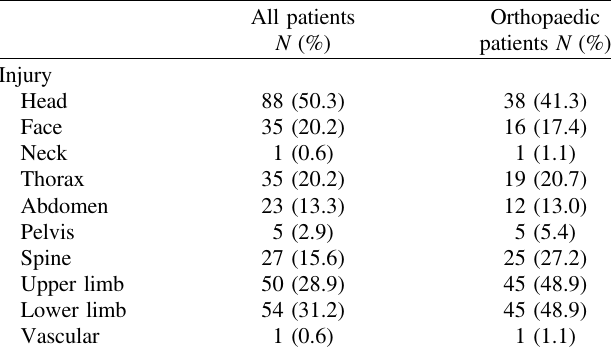
Table 2. Comparison of injuries in all patients versus orthopaedic